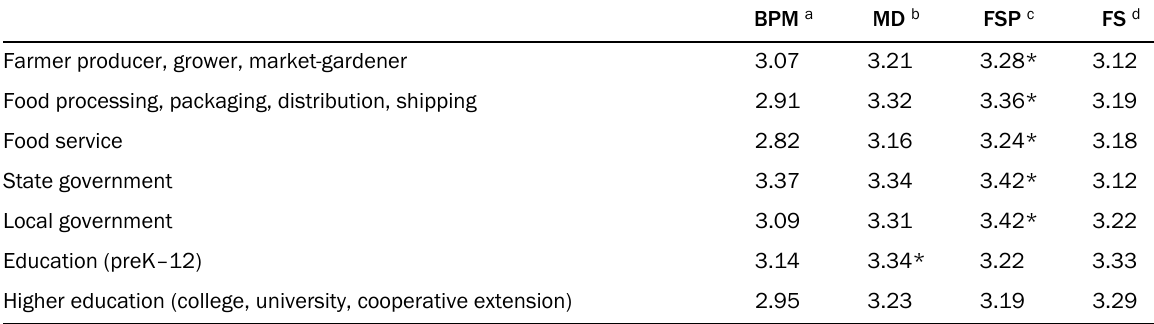
Table 5. Priority Ranking of Survey Categories by Respondents’ Occupation